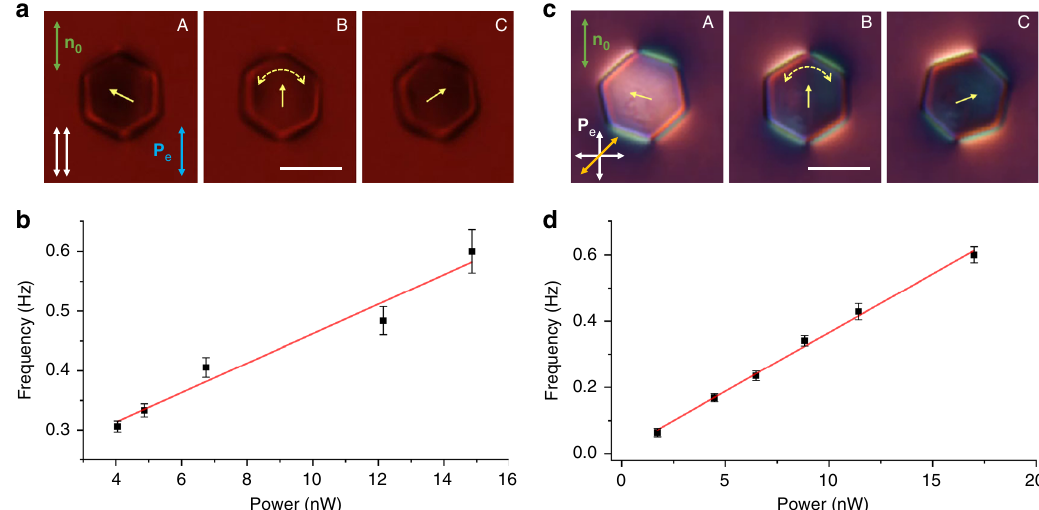
Fig. 3 Light-driven periodic angular oscillations of colloidal particles. a Frames from a polarizing optical microscopy video (Supplementary Movie 4) showing oscillation of a micro-platelet within an angular range <180° in a 7 µ m cell at low intensity of blue excitation light. Frames A and C show the micro- platelet at the two extreme angular displacements. Images were taken under parallel polarizers (white double arrows). Polarization direction of the blue excitation light (marked with a blue double arrow) is along the far- fi led director n 0 . b Oscillation frequency as a function of the optical excitation power of blue light delivered to such a particle. c Frames from a polarizing microscopy video (Supplementary Movie 5) showing oscillation of a micro-platelet in a 4 µ m cell under white light illumination. Frames A and C depict the micro-platelet at the extreme angular displacement. Images were taken using crossed polarizer and analyzer in the polarizing microscope, with an additional 530 nm retardation plate inserted between polarizers after the sample. Orientation of crossed polarizers and the quarter-wave plate ’ s slow axis are shown with crossed white arrows and a yellow double arrow, respectively. Note that white light was used here as both the imaging and excitation light source and its polarization P e was also set to be along n 0 . d Oscillation frequency as a function of the optical power of white light. Scale bars are 5 µ m. Data points in b and d are mean ± s.e.m; red lines are for eye guiding